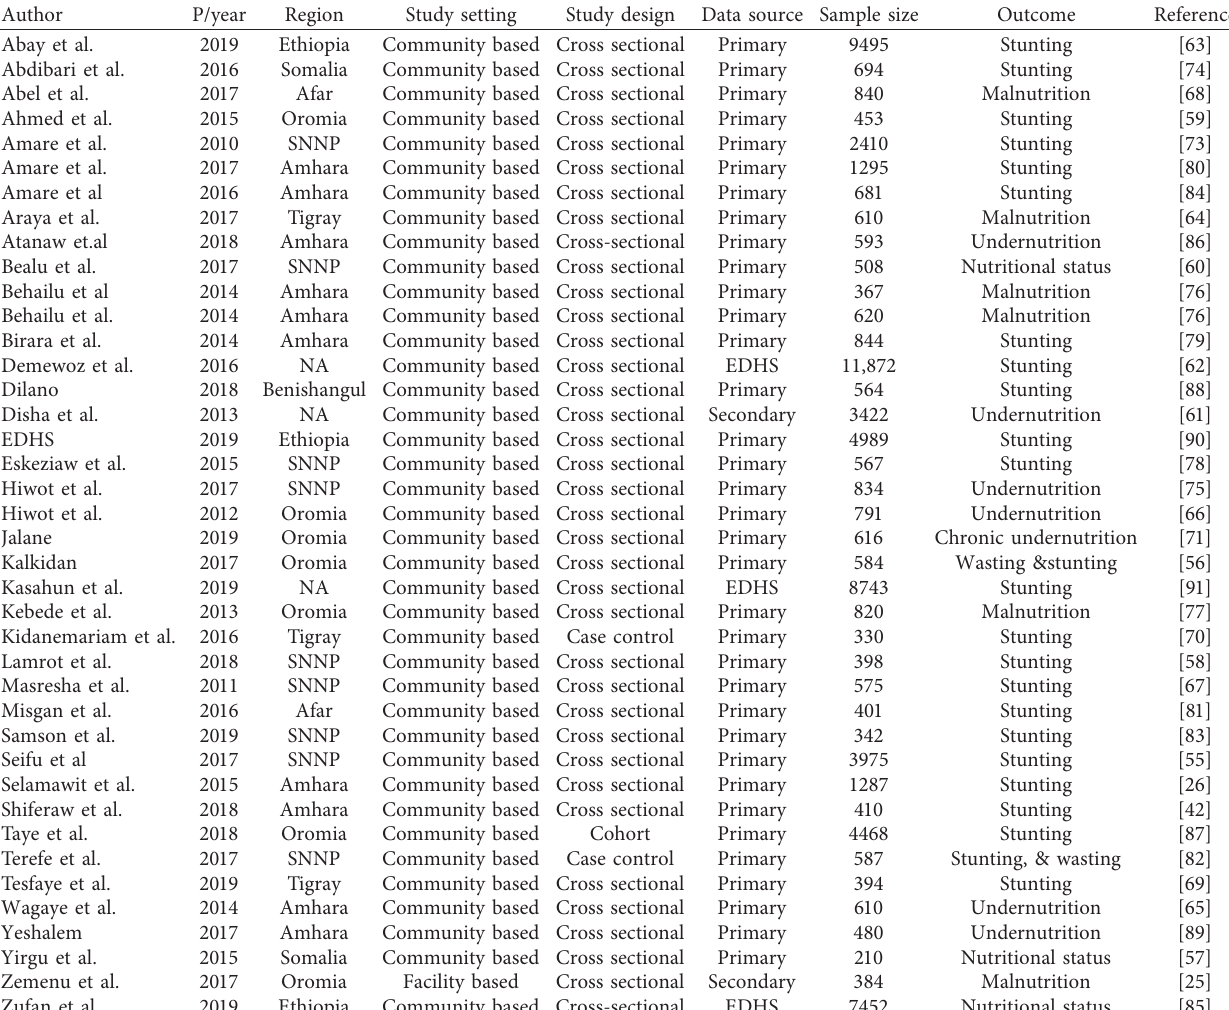
Table 1: Summary of included studies in assessing prevalence and associated factors of stunting in Ethiopia, 2010–2019 [68–82].